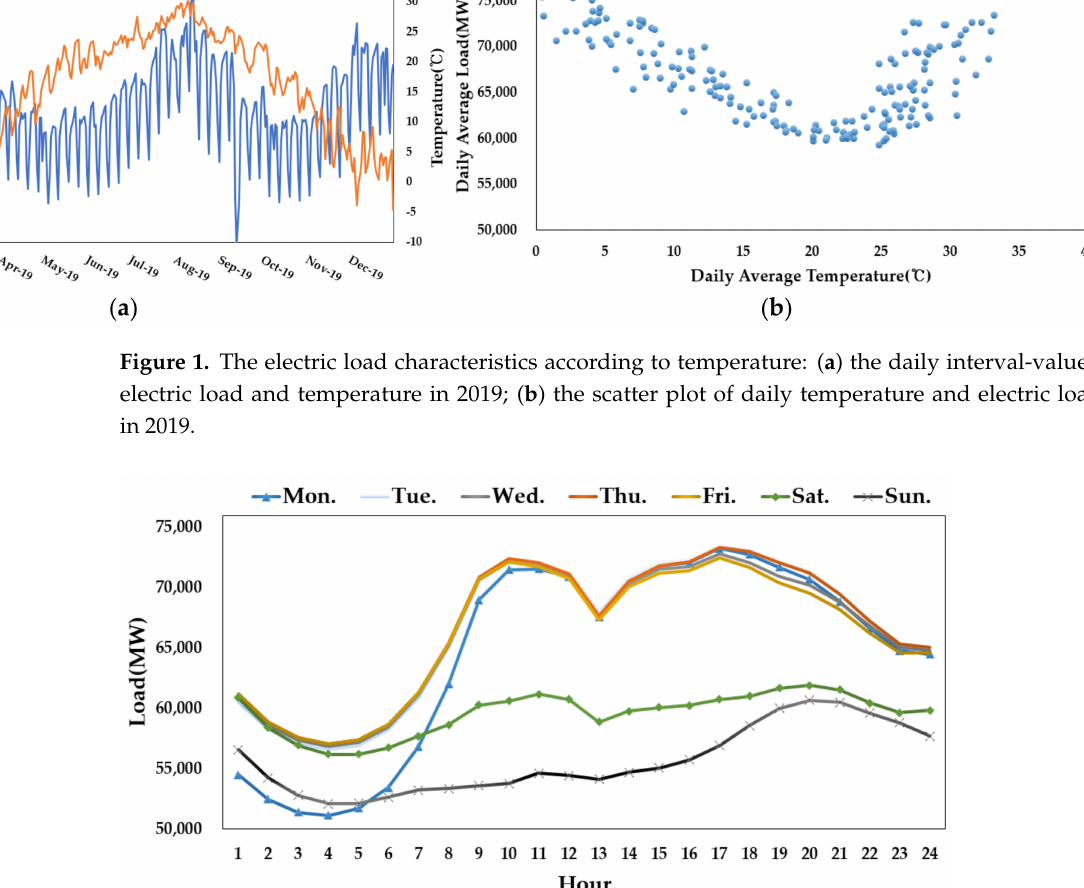
tors that do not meter the amount of generation in real-time is increasing. Electric load in South Korea refers to the amount of generation metered at the generator output